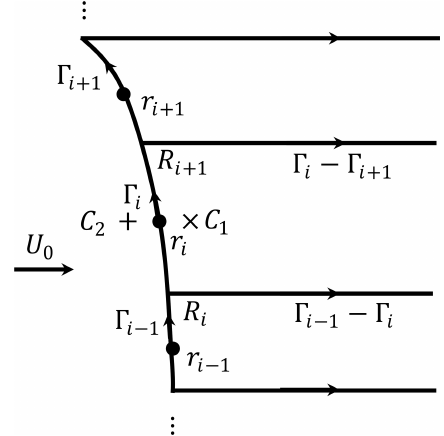
Figure 6. Side view of a part of the axisymmetric vortex system of the non-planar rotor. The bound vorticity and trailed vorticity are highlighted. The two points of interest are marked with × and + , which are just inside and outside the section i . The two circular contours of C 1 and C 2 pass through the two points of